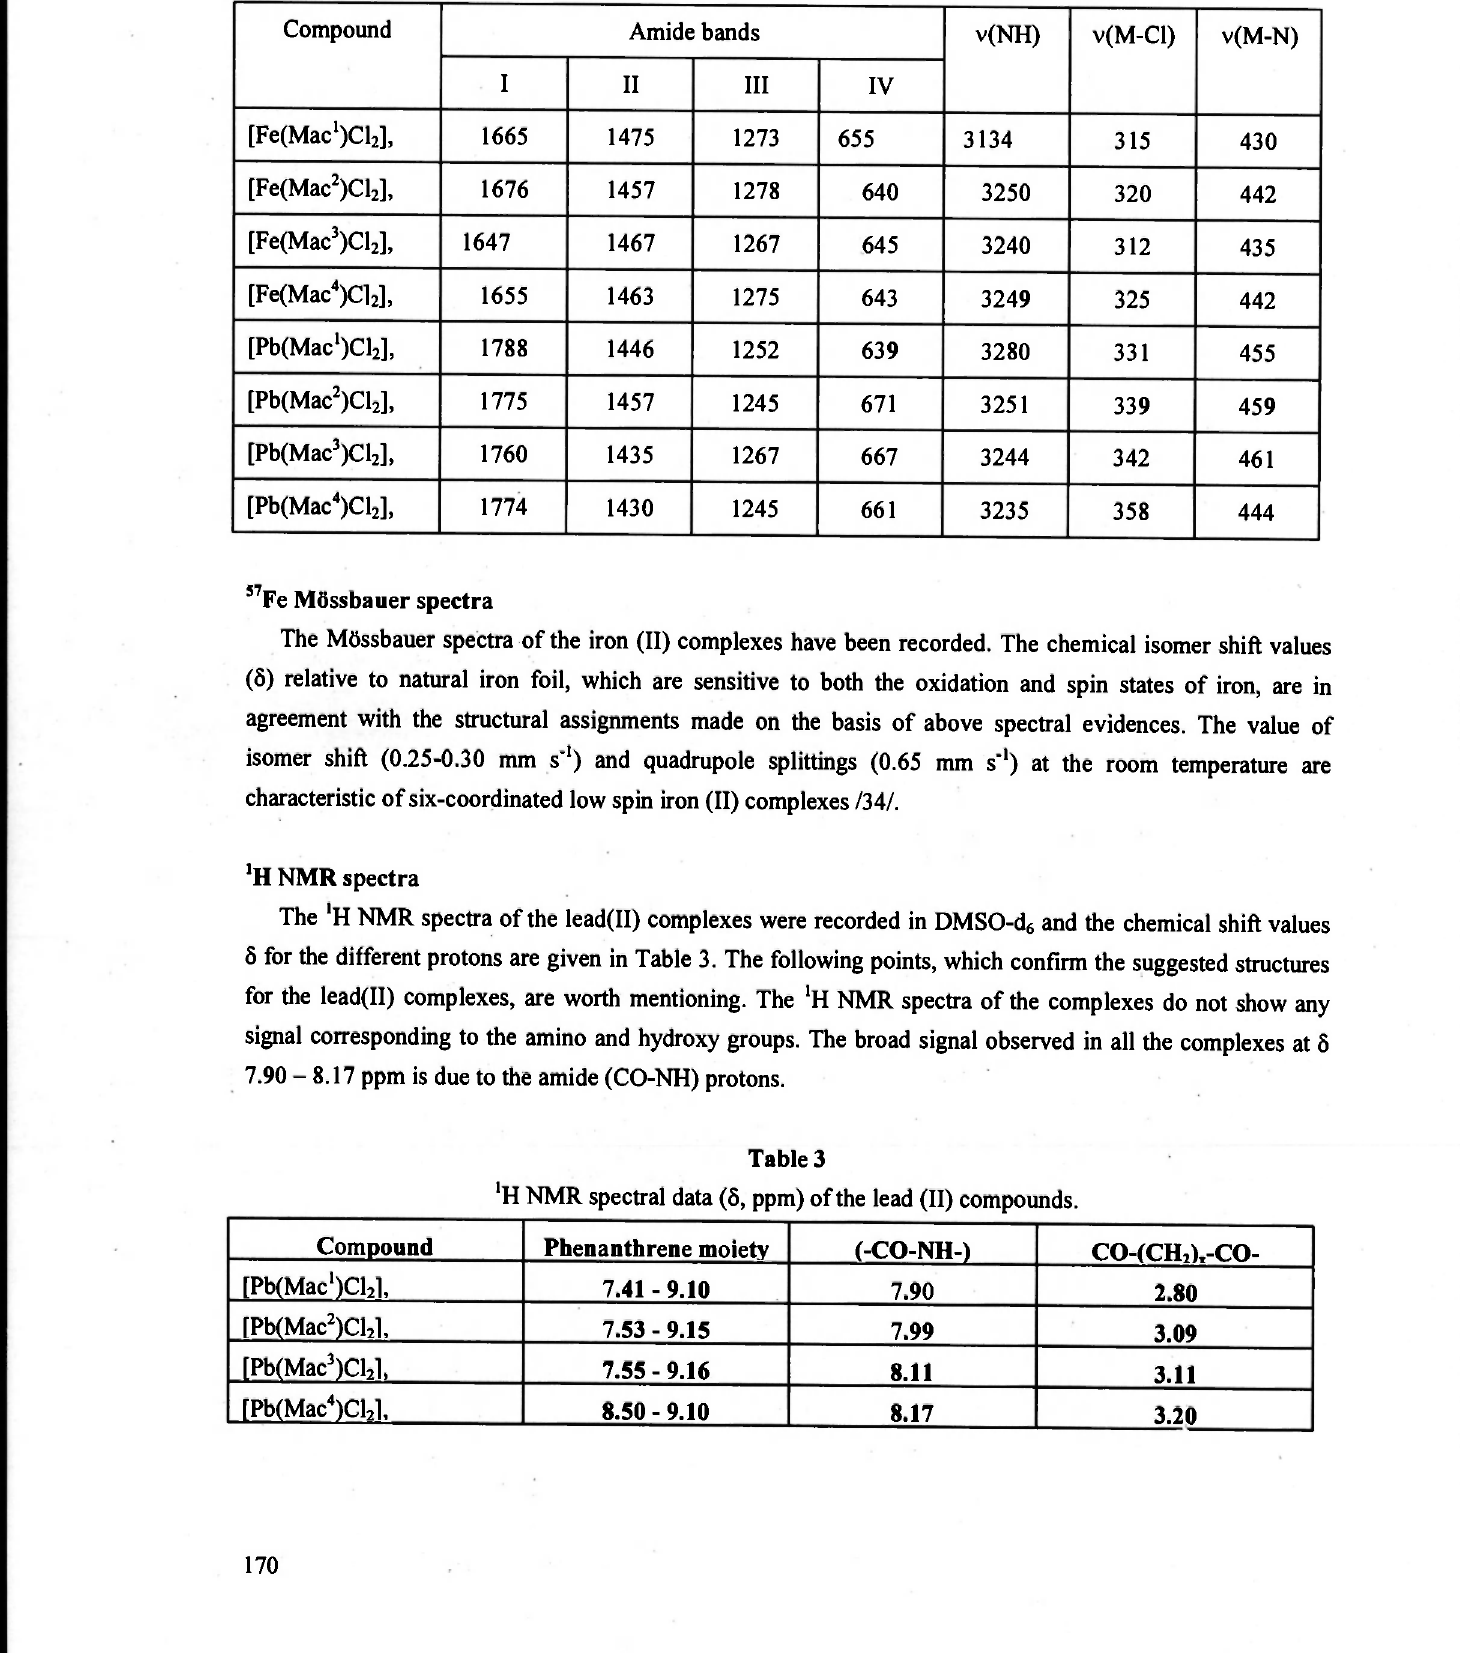
IR Spectral Data (Cm" 1 ) of the Iron(II) and Lead(II) Macrocyclic Complexes.